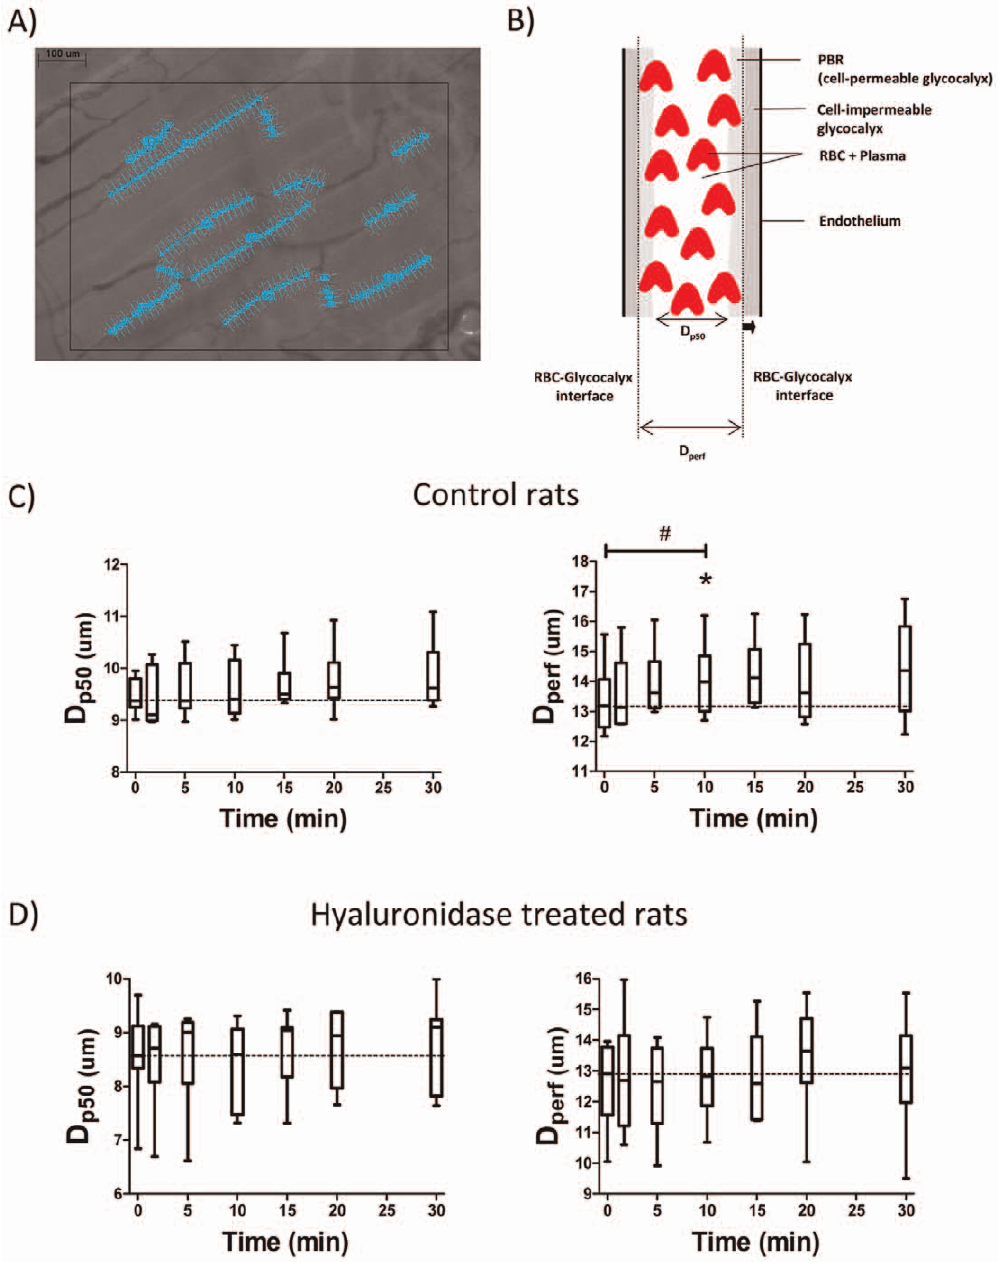
Figure 1. Example of a single SDF image of rat gastrocnemius microcirculation is shown in panel A. From each movie (total length: 40 frames) recorded by the SDF camera the distribution of the width of the red blood cell (RBC) column in each microvessel that fitted the criteria of the analysis (a) in focus, b) had a sufficient length and were not close to bifurcations, and c) were continuously filled with RBCs and did not contain plasma gaps) was determined along the vessel by placement of lines 6 every 10 m m perpendicular to the vessel direction (as shown by numbered lines in image), and calculating the full width at half maximum of the intensity profile 10 times in front and 10 times behind each line frame by frame in all 40 consecutive frames (see methods). Per vessel, the D P50 and D perf , by linear extrapolation of the distribution of RBC column width, were determined, revealing the perfused boundary region (PBR), which includes the cell-permeable part of the glycocalyx (see Discussion, page 16). Between the PBR and the endothelium the cell-impermeable glycocalyx resides. An increase in the accessibility of this part of the glycocalyx for the flowing RBCs is associated with an outward movement of the RBC-glycocalyx interface as shown by the thick arrow in panel B. Effects of insulin on the D p50 and D perf in control rats (n=6) are shown in panel C and effect of insulin on the D p50 and D Perf in hyaluronidase treated rats (n=7) are shown in panel D. # , P , 0.05 (1-way ANOVA), *, P , 0.05 versus baseline (t=0) (Tukey’s post hoc test). groups with a n . 6 and the Shapiro Kolmogorov-Smirnov test for All data are presented as means 6 SD; coefficient of variation is expressed as (SD/mean 6 100%). The normality of the data was groups with a n , 6. If data were not normally distributed, the checked with the D’Agostino & Pearson omnibus normality test for range (minimum to maximum) has been added. The effect of